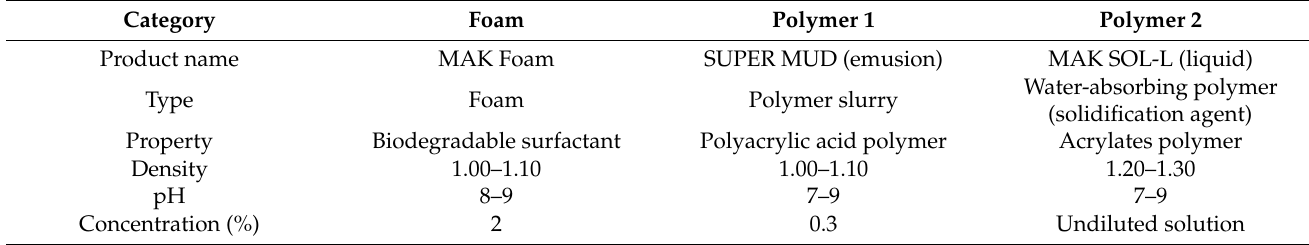
Table 2. Properties of conditioning agents used in the